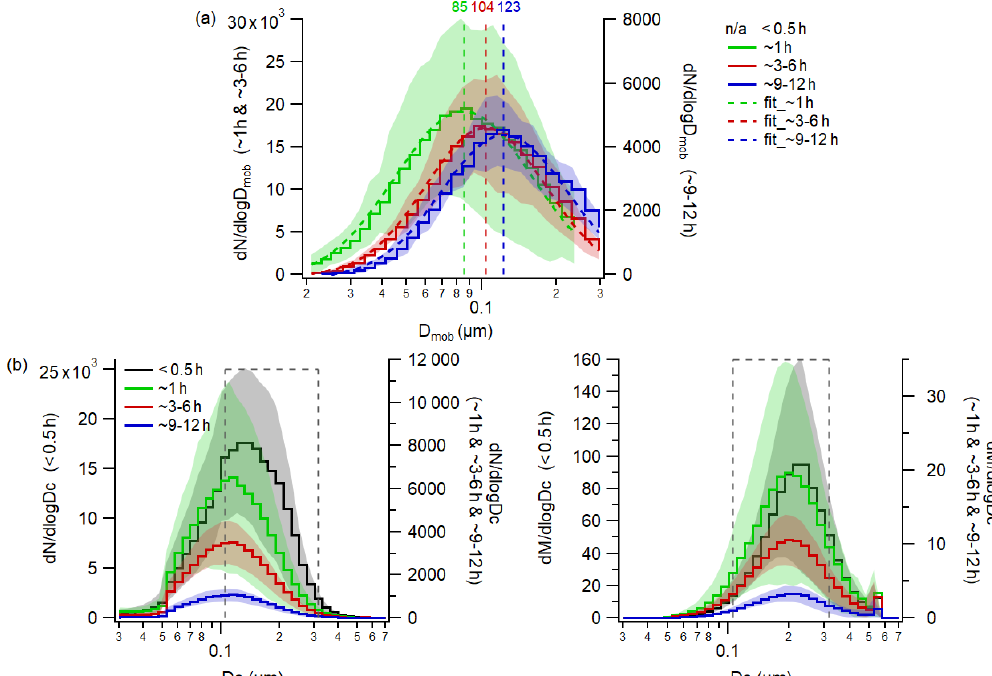
Figure 4. (a) The mean number size distributions of sampled smoke aerosols measured from the SMPS. The lognormal fitted CMDs are also specified (in nanometres) for aerosols at different ages. The shade areas represent 1 standard deviation. (b) The mean number (left) and mass (right) distributions of the BC core as a function of the sphere-equivalent diameter for sampled smoke plumes at different ages. The shaded areas represent 1 standard deviation. The grey dashed square regions show the range of BC core diameter used for calculating coating